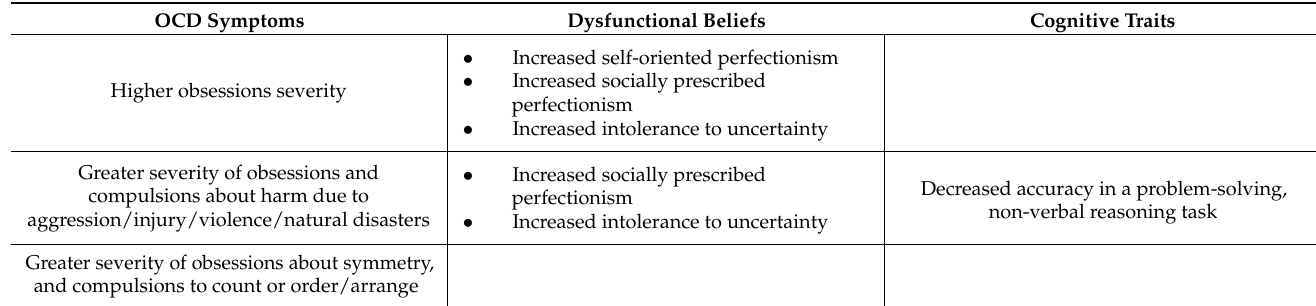
Table 4. Summary of correlational analysis results FDR